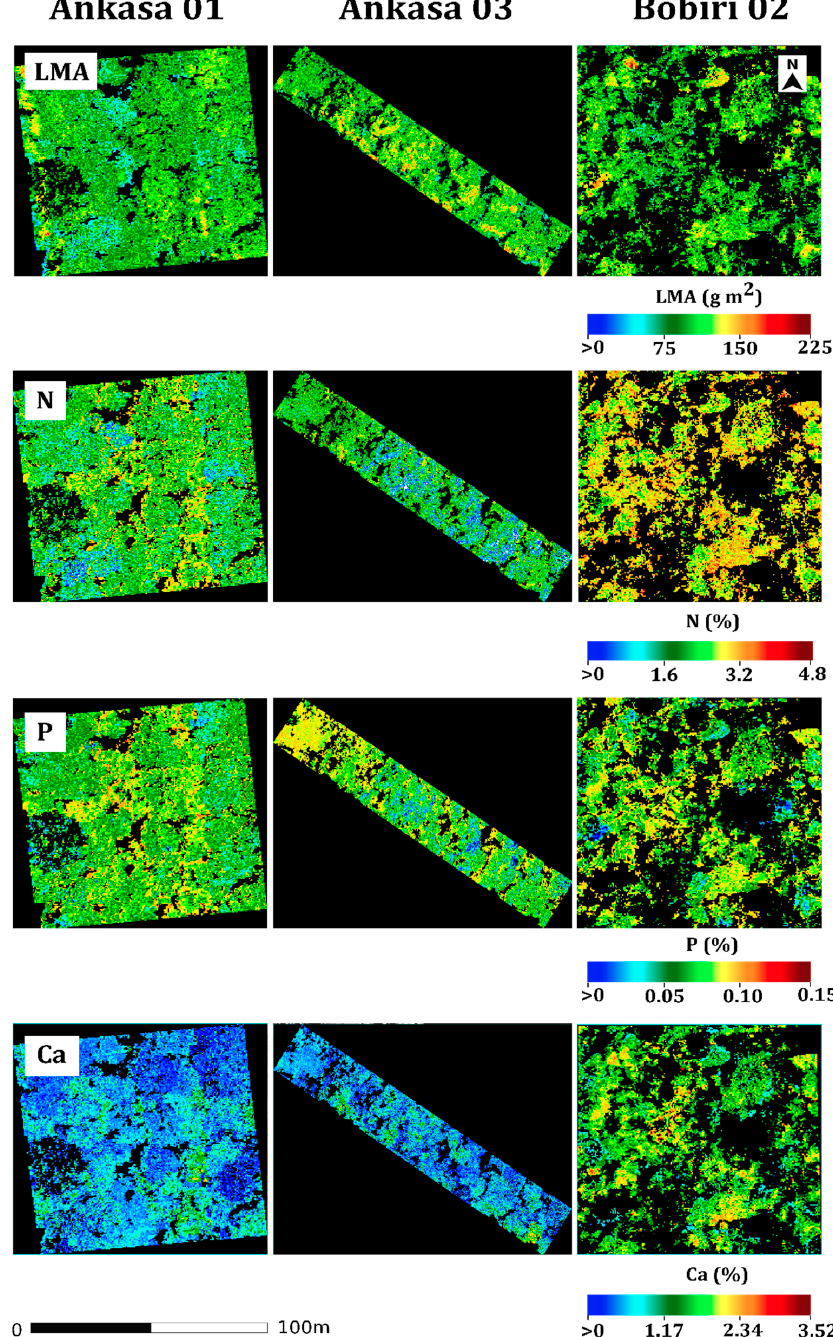
Figure 5. Maps of forest canopy LMA, N, P and Ca for three one-ha tropical forest plots in Ghana, West Africa. Created using the regression coefficients generated from the PLSR analyses in Table 2, applied to each pixel of the hyperspectral canopy data using Formula (1). Black areas represent shadows or areas with an NDVI < 0.6. Pixel resolution = 0.5